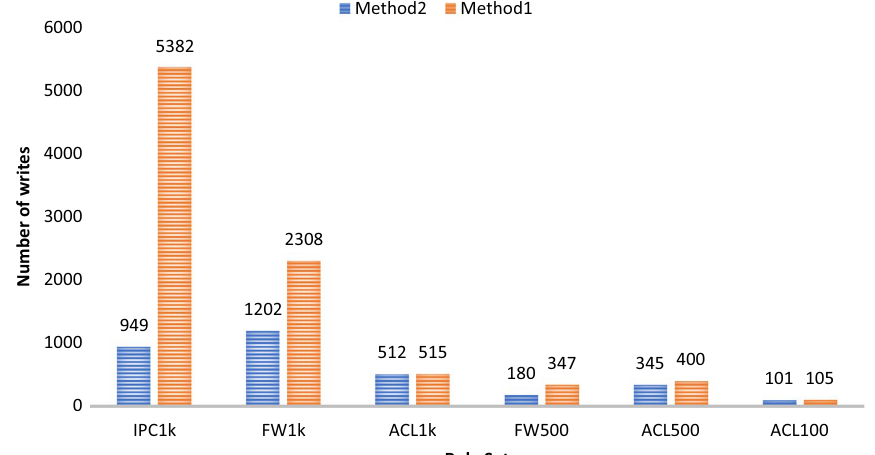
Fig. 11 Number of writes required for adding a rule